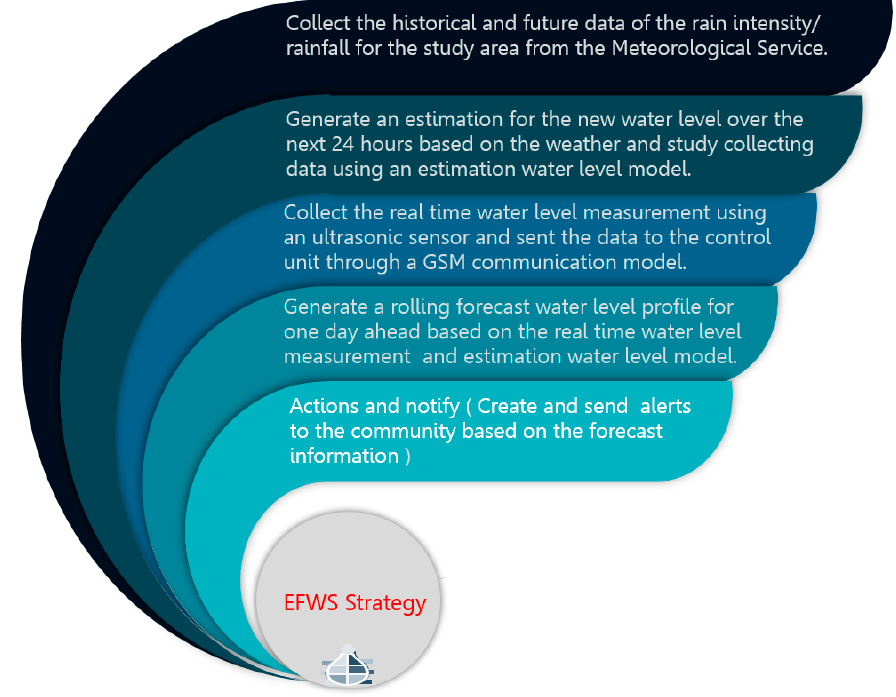
Figure 2. The basic strategy principle of EFWS.